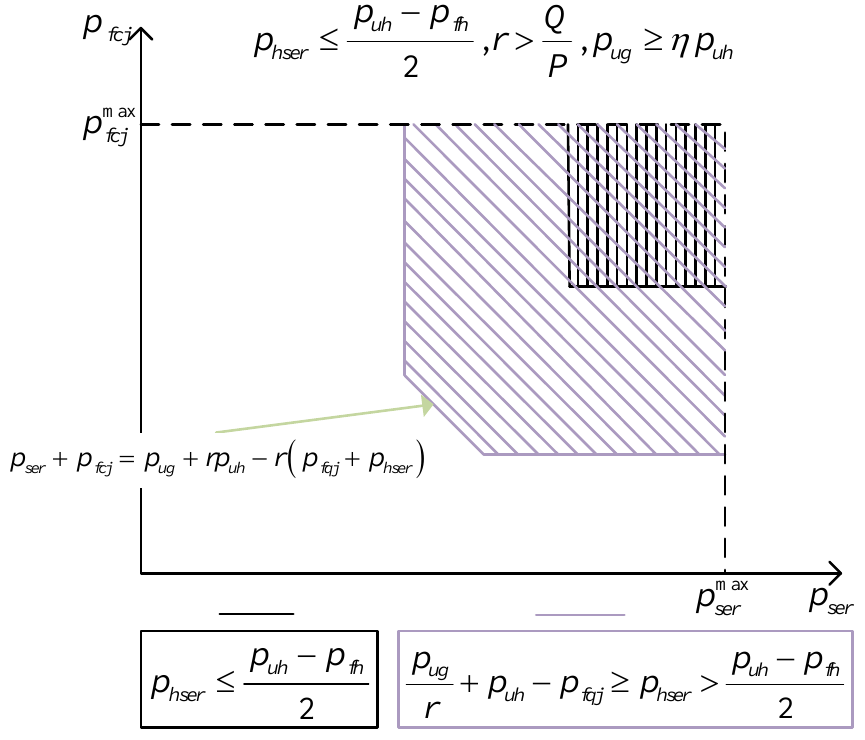
Figure A4. Scenarios 3,4: two-dimensional sketch of the tripartite game Nash equilibria.